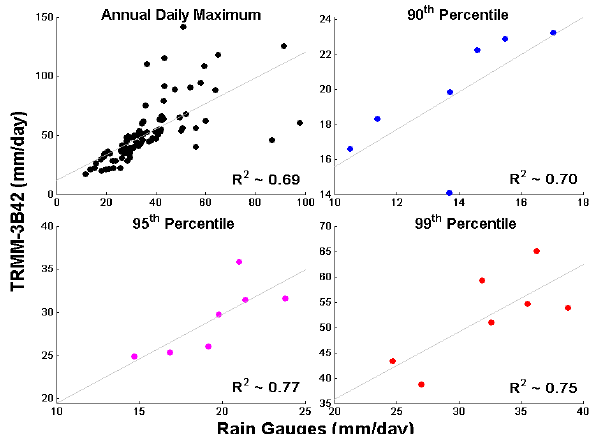
Fig 3. Correlations of the annual daily maximum rainfalls and the 90 th , 95 th , 99 th percentiles between rain gauges and TRMM 3B42 grid cells.